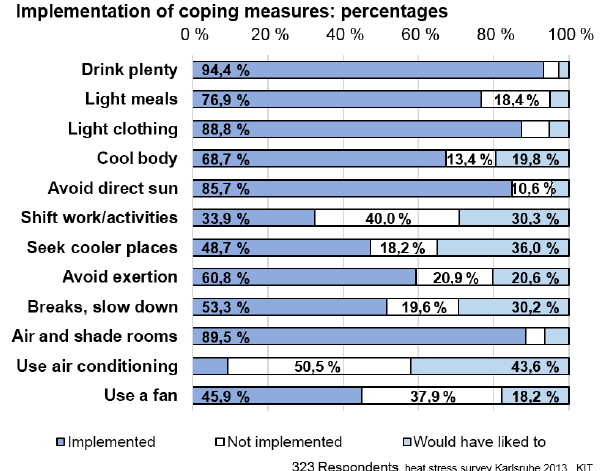
Figure 6. Implementation of coping measures: percentages of re- spondents. Exact numbers for percentages below 10% are not indi- cated in the